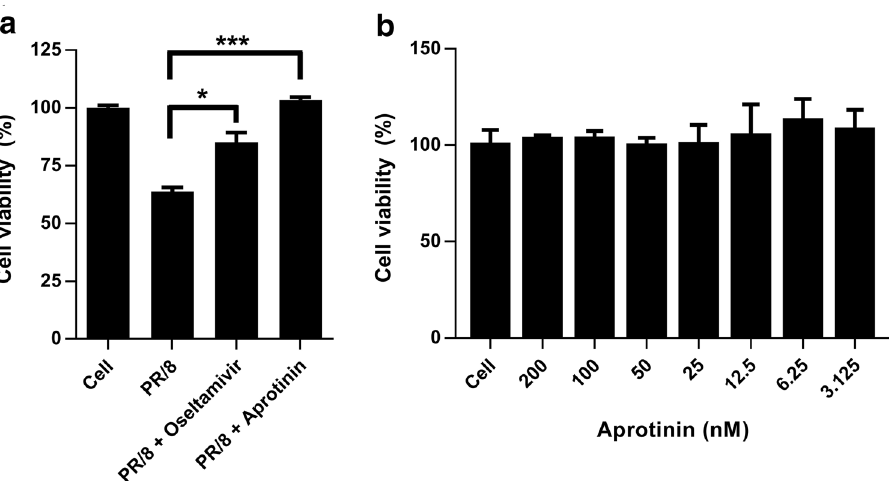
Figure 2. Antiviral effects of aprotinin compared with oseltamivir and cytotoxicity assay in Madin–Darby canine kidney (MDCK) cells. ( a ) MDCK cells were infected with A/PR/8/34 (1000 TCID 50 /ml) and treated with 60 nM aprotinin or 100 μM oseltamivir. Untreated and uninfected MDCK cells (cell) and untreated infected cells (PR/8) were used as controls. ( b ) To determine the cytotoxicity of aprotinin, cell viability was measured by treating the MDCK cells with the compound for 72 h, and cell viability was compared with untreated control cells (cell). Cell viability was measured using EZ-Cytox. The experiments were performed in triplicate. * P < 0.05, ** P < 0.01, and *** P < 0.001. TCID 50 : median tissue culture infectious